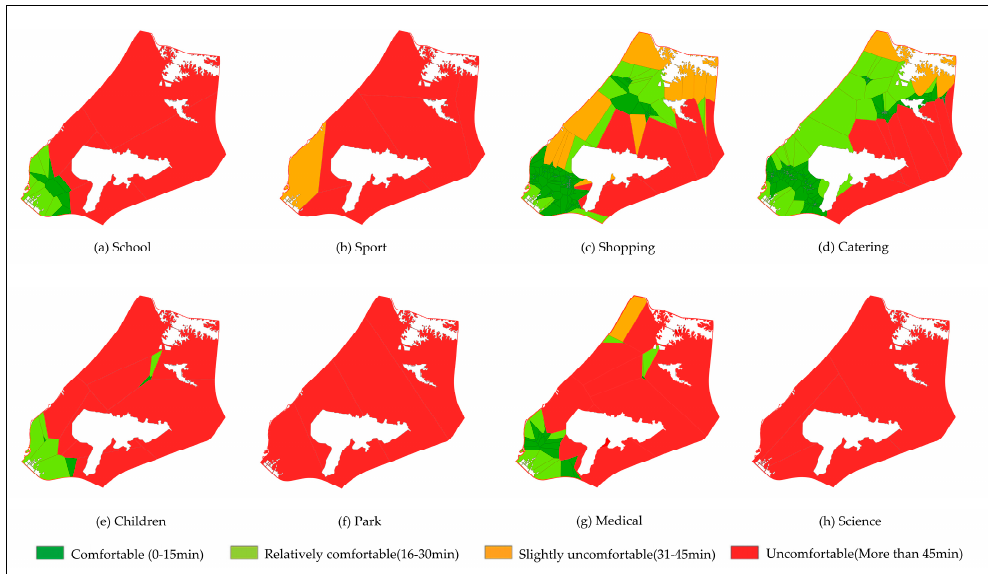
Figure 6. Residents’ accessibility to public services.